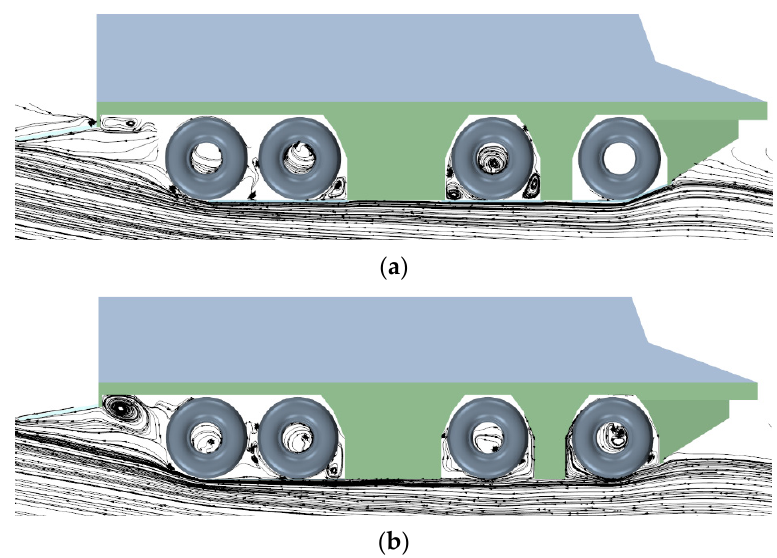
Figure 21. The streamline distribution of the resistance improvement model at Fr = 0.624. ( a ) The streamline distribution of the Model-2; ( b ) The streamline distribution of the Model-3.